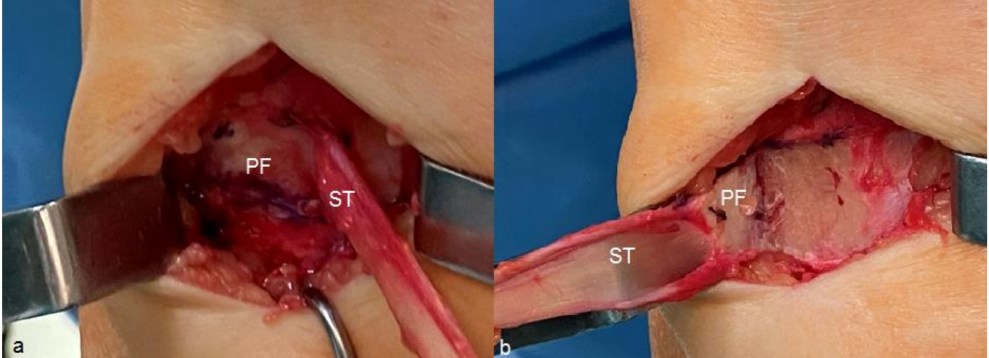
Figure 2. Harvesting of a semitendinosus tendon graft with an adjacent periosteum: ( a ) Exposed distal semitendinosus (ST) attachment with an adjacent periosteal flap (PF) (marked violet); ( b ) Harvested semitendinosus tendon graft with an adjacent periosteal flap.